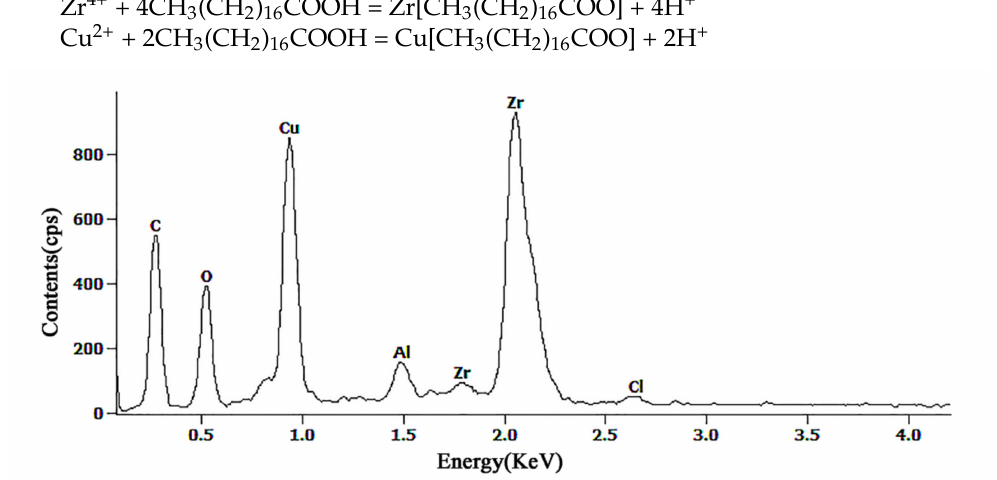
Figure 3. Surface energy spectrum of the surface after